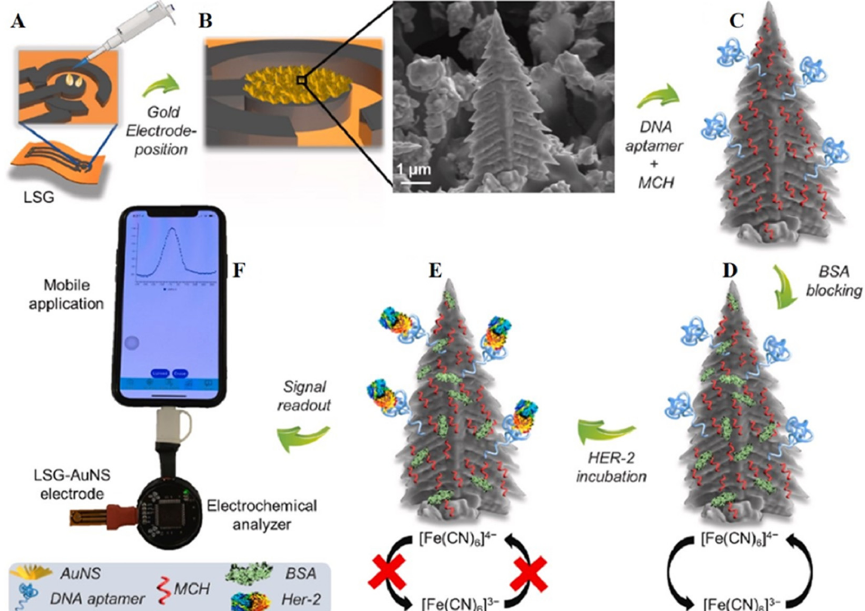
Figure 6. The schematic diagram for the formation of laser-induced graphene (LIG) electrode sensor. ( A ) LIG electrode on polyimide sheet, ( B ) Formation of Au nanostructures on working electrode area with electrodeposition, inset shows the SEM images of the tree-like structure of Au. ( C ) Bindings of DNA aptamer on the electrode through self-assembly of mecaptohexanol (MCH), ( D ) Surface blocking procedures with BSA and measurement of electrochemical signal with [Fe(CN) 6 ] 3 − /4 − redox probe, ( E ) Incubation with the HER-2 antigen and measurement of EC signal, and ( F ) Quantification of HER-2 by evaluating the electrochemical signal. Reprinted with permission from Ref. [39]. Copyright